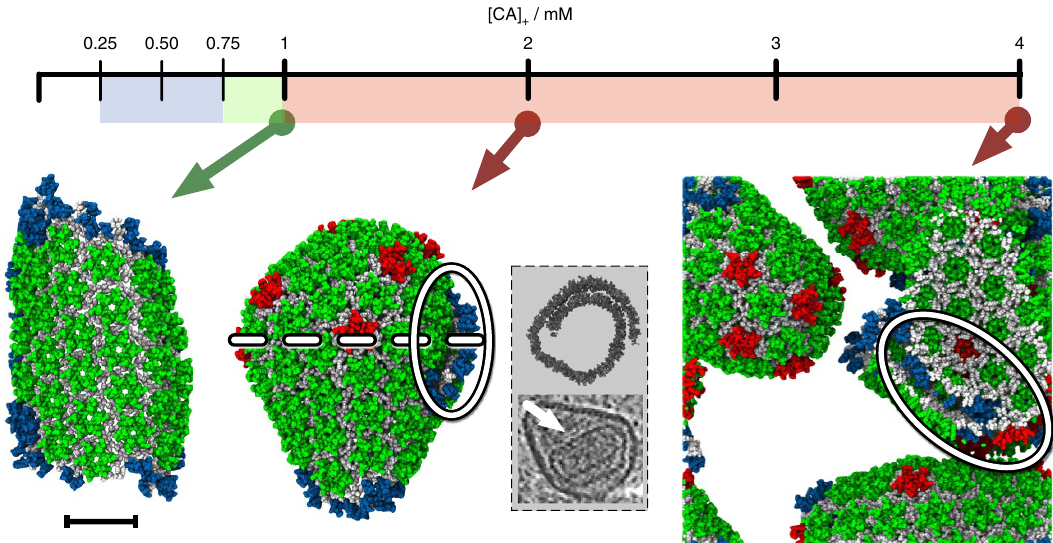
Table 2 | CG self-assembly for fixed ‘active’ CA concentrations [CA] ‘Active’ CA concentration, [CA] þ